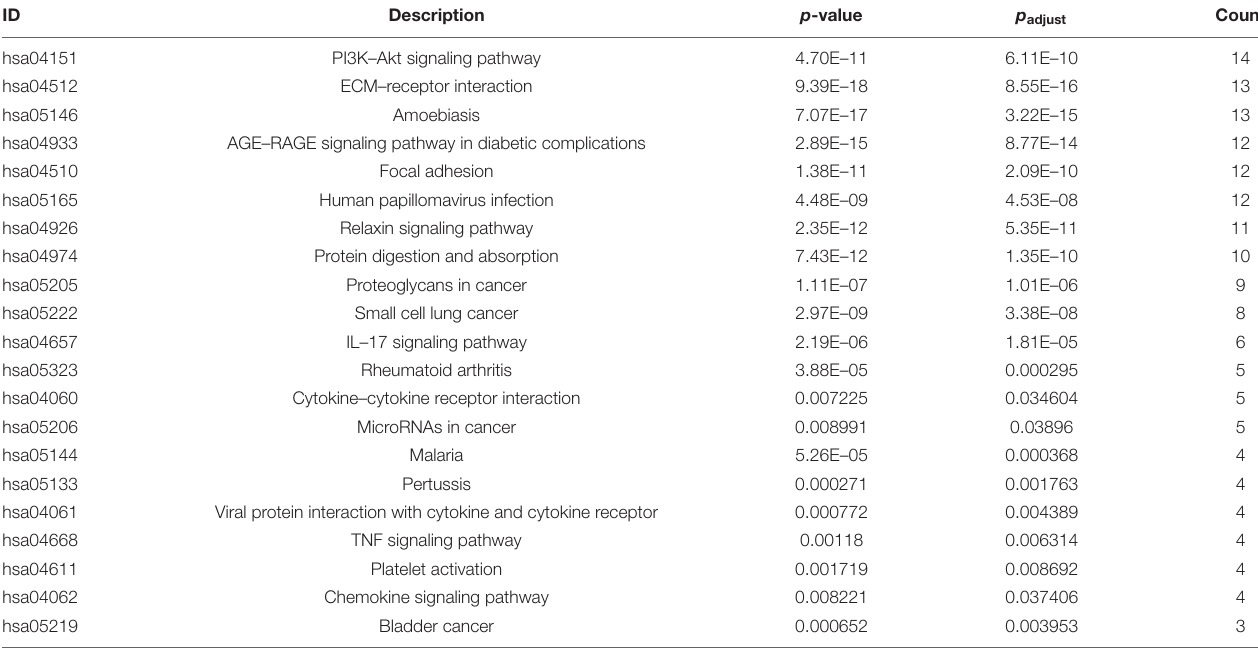
TABLE 1 | Signaling pathway enrichment of MMP9 and COL3A1 interacting genes.